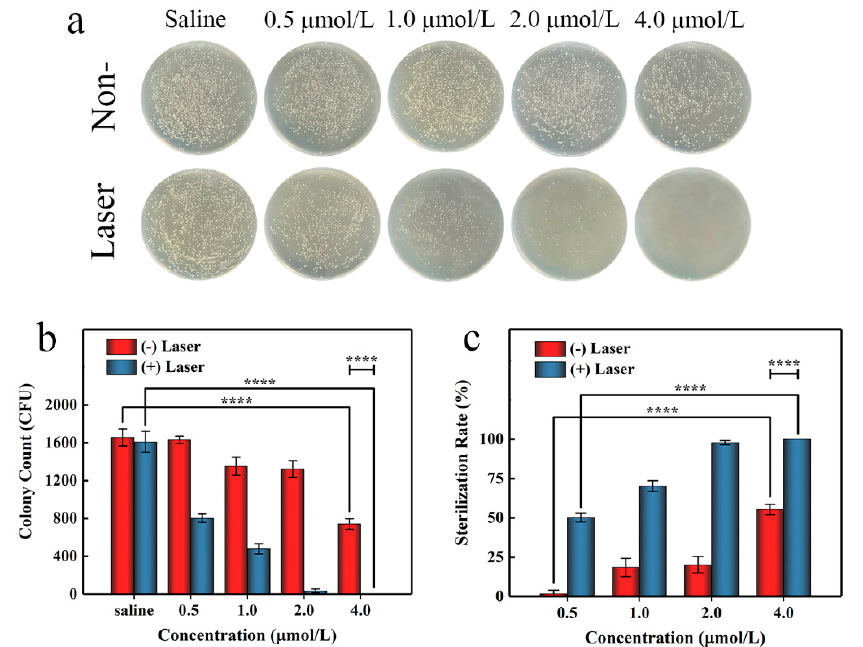
Figure 7. In vitro antibacterial performance of AgTMPPS against MRSA at different concentrations with or without 360 J/cm 2 light irradiation (460 nm). ( a ) Photographs of the LB agar plate. ( b ) Cor- responding CFU count. ( c ) MRSA sterilization rate. The asterisks indicate significant differences ( p values: **** p < 0.0001). All values are expressed as mean ± SD, n = 3. Table 3. Bacterial colony count of MRSA and the calculated sterilization rate for treatment with AgTMPPS at different concentrations a .